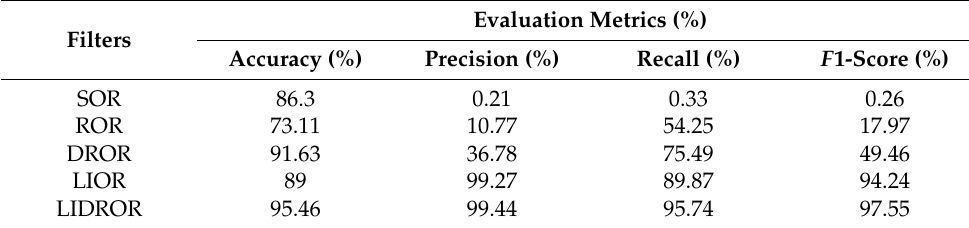
Table 5. Evaluation